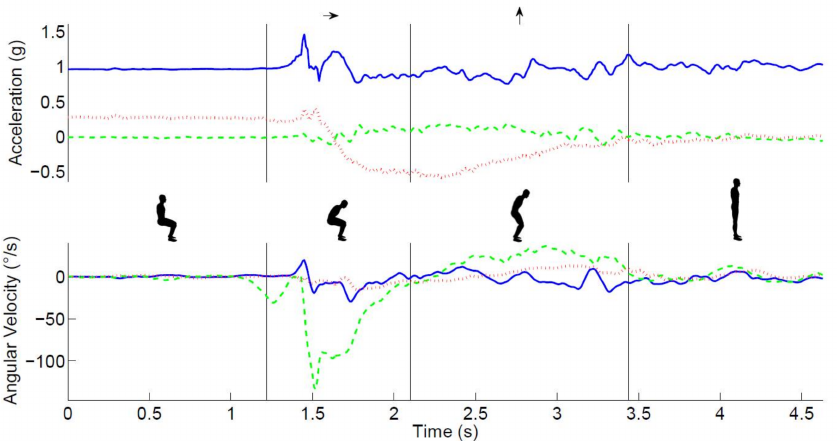
Figure 2. The main phases of the STS movement. The top panel shows the time series of raw acceleration (green/dashed-mediolateral, red/dotted anteroposterior, and blue/solid vertical), the lower panel shows the angular velocity (green/dashed-pitch, red/dotted-roll, and blue/solid -yaw) signals, and the insets illustrate the main phases of the STS movement, which are separated by vertical lines in both